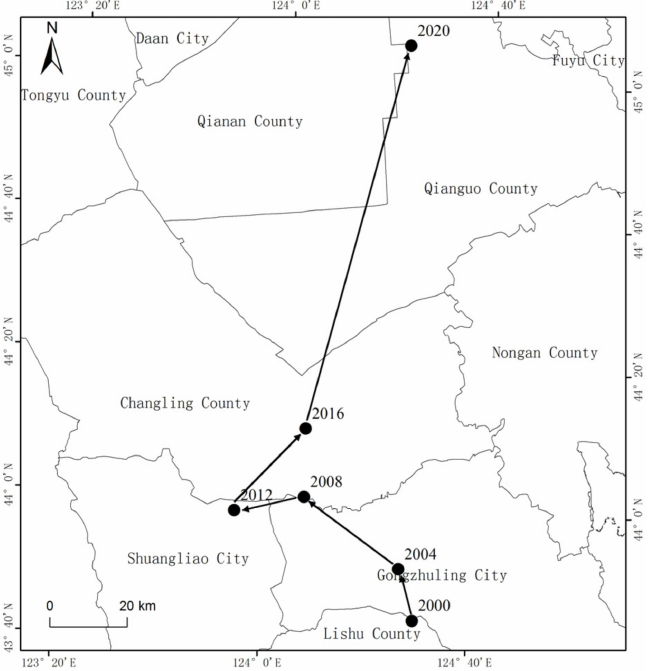
Figure 4. Analysis of the center of gravity shift of carbon emission intensity in Northeast